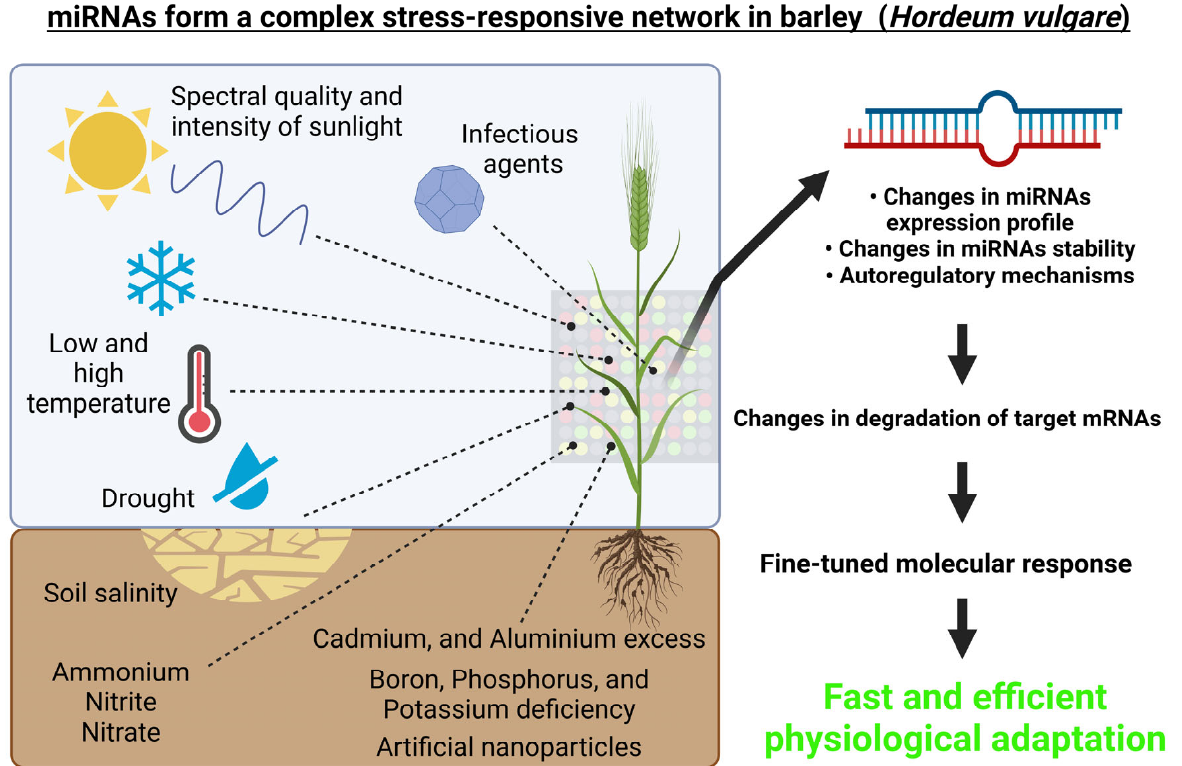
Figure 3. miRNAs form a complex regulatory network in barley ( Hordeum vulgare ). Environmental